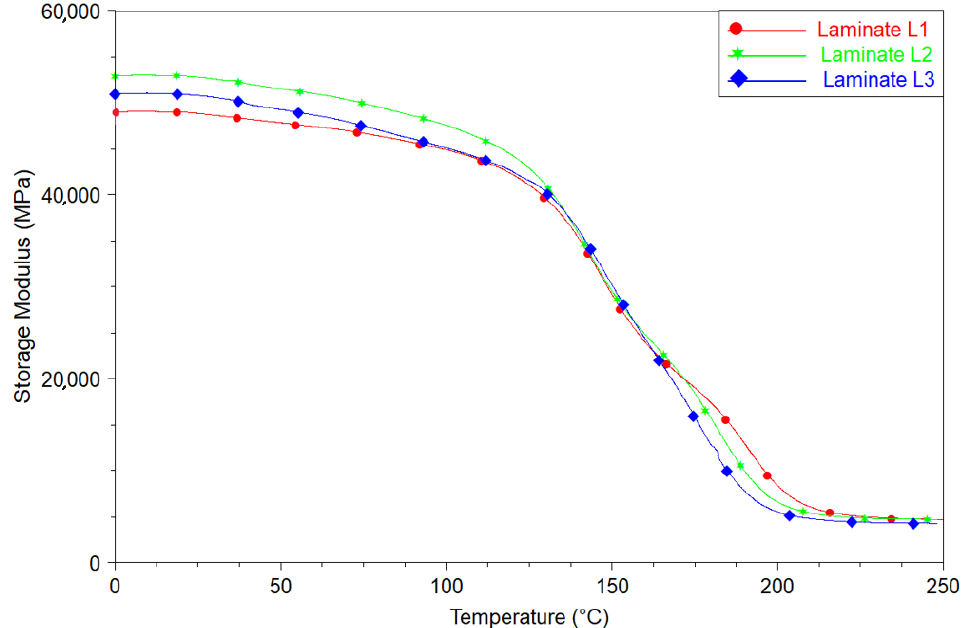
Figure 11. Storage modulus of reference (L1) and modified (L2, L3) laminates.